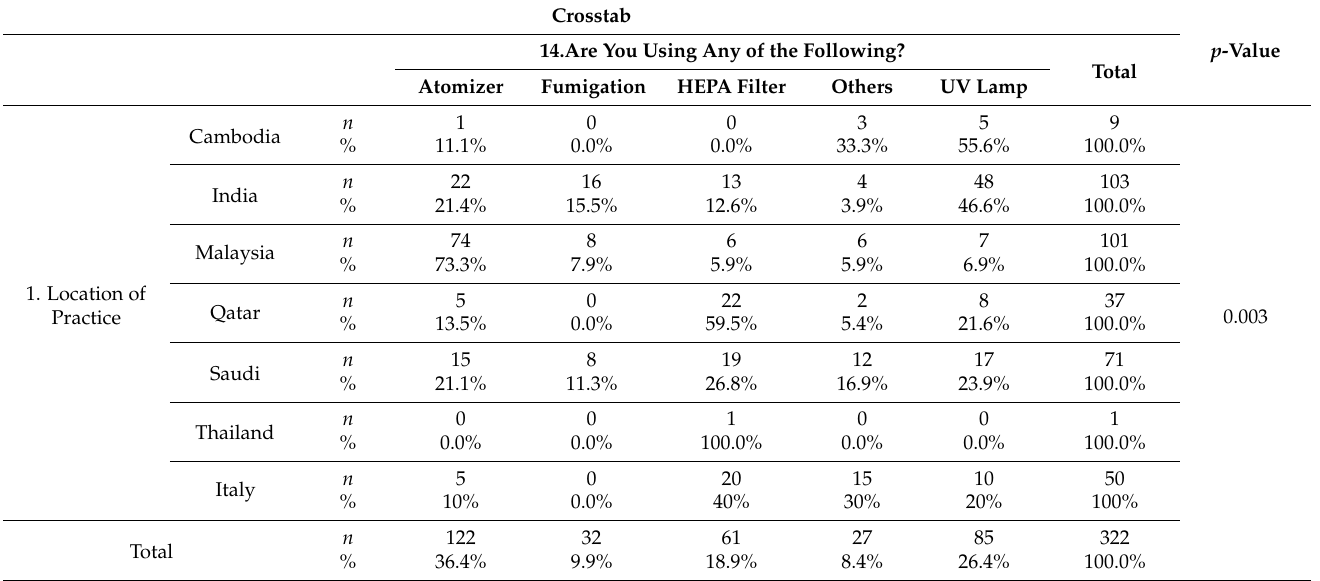
Table 4. Differences between the implementation of protective measures/devices in dental clinics in different countries.